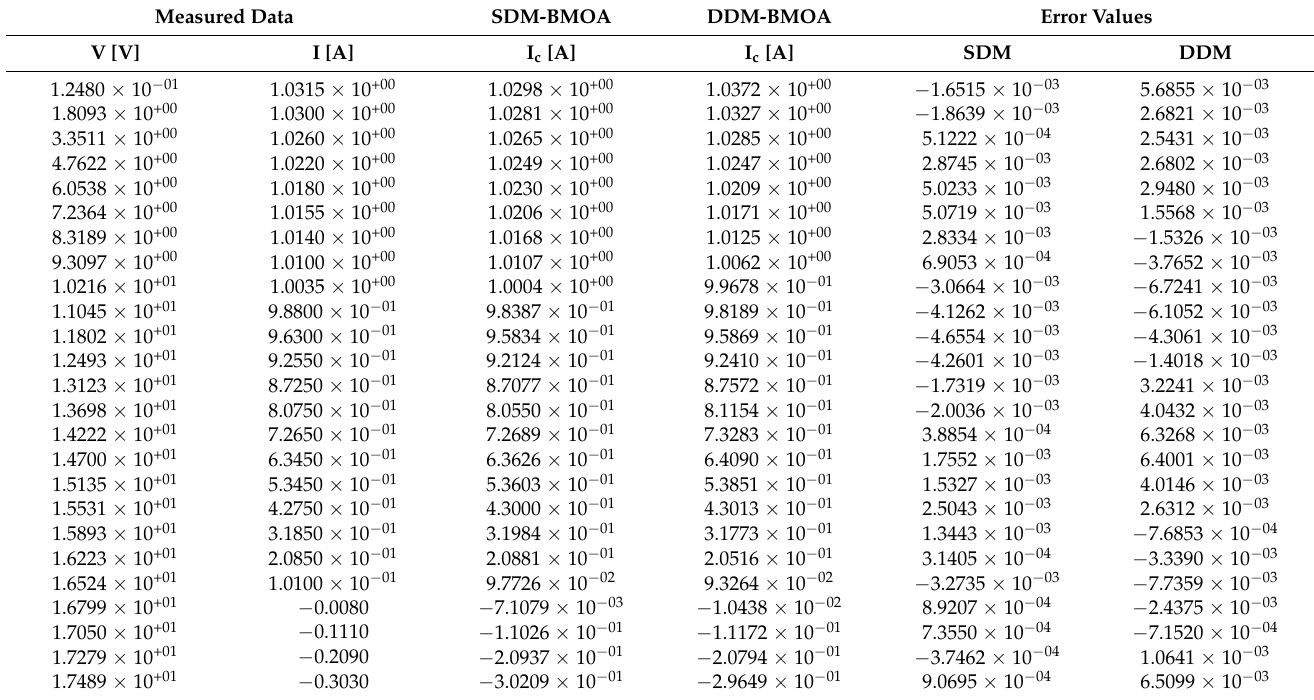
Table 11. (I, V) points of the PWP201 photovoltaic panel.